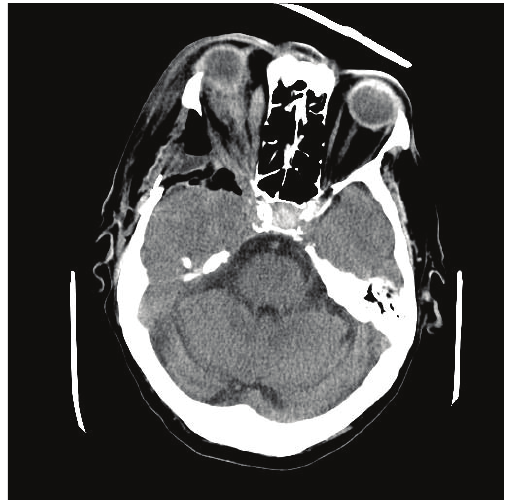
Figure 3: Axial post-operative CT scan demonstrating orbital